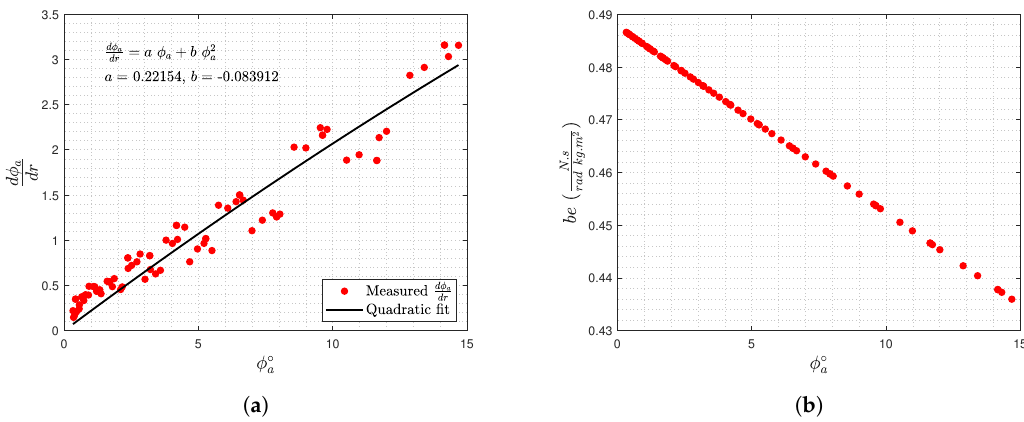
Figure 4. Equivalent linear damping coefficient estimation using Froude energy method with linear and quadratic damping terms, test case 8 by combining results of 4 tests with different initial roll angles, see Section 3.3. ( a ) Estimation of extinction coefficients a and b using quadratic curve fitting, Equation (22); ( b ) Equivalent linear damping coefficient be estimation based on the extinction coefficients a and b using Equation